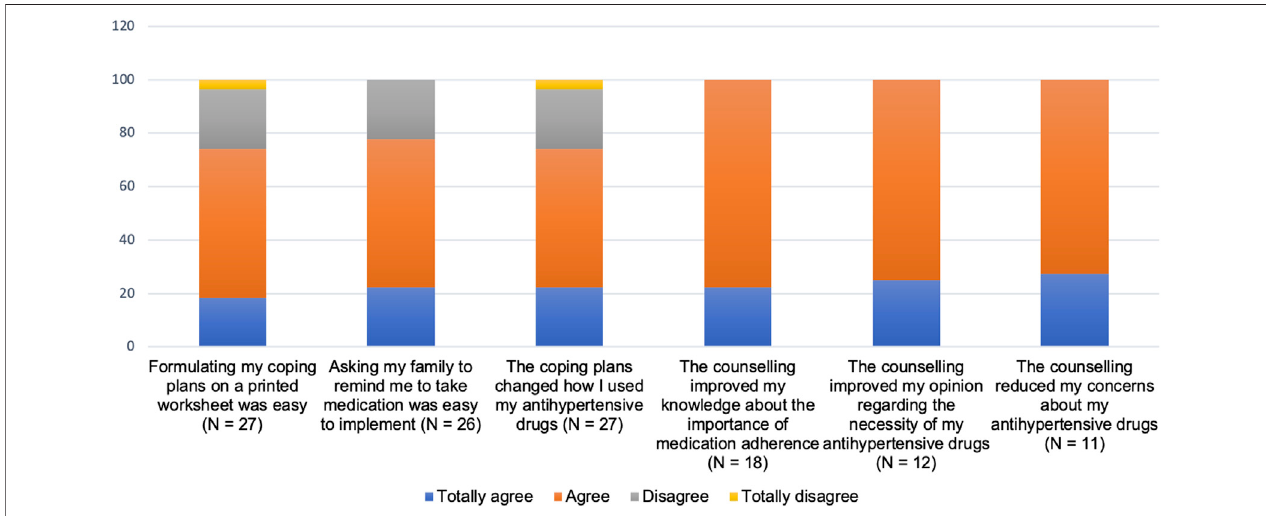
FIGURE 3 | Patients ’ experiences with implementing each component of the intervention based on barrier(s) for adherence identi fi ed.